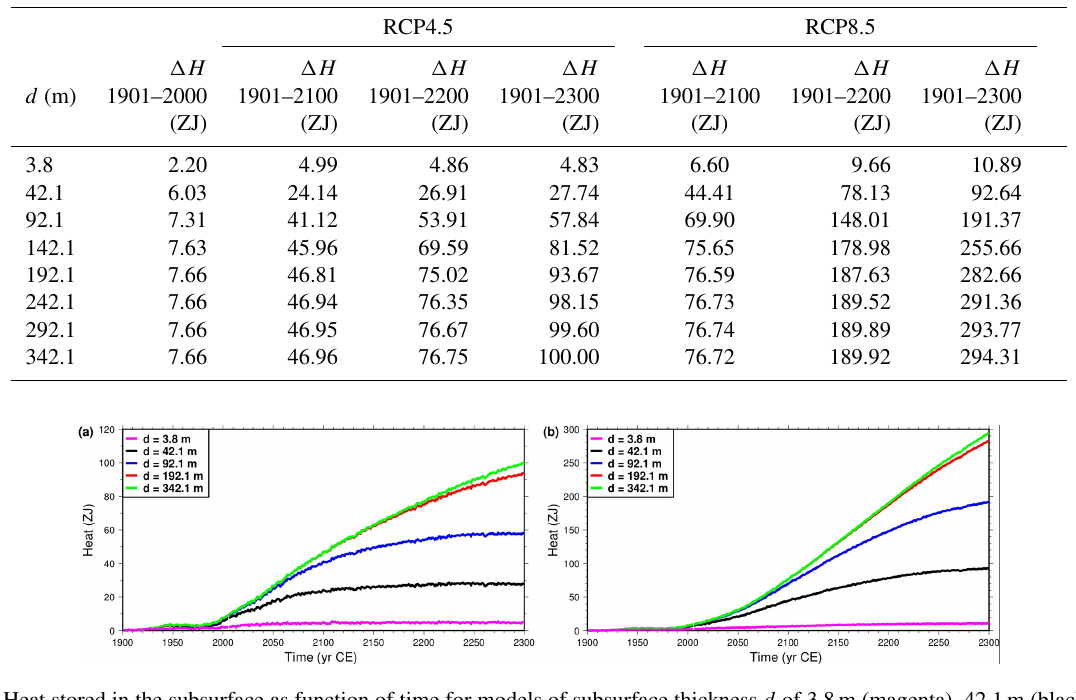
Figure 6. Heat stored in the subsurface as function of time for models of subsurface thickness d of 3.8m (magenta), 42.1m (black), 92.1m (blue), 192.1m (red) and 342.1m (green). (a) Simulations forced with CRUNCEP+RCP4.5 data. (b) Simulations forced with CRUNCEP